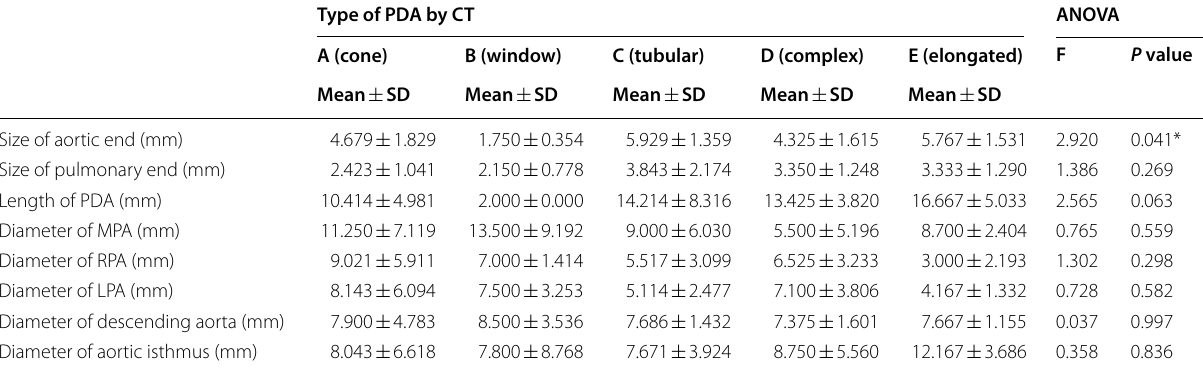
* significant p value (<